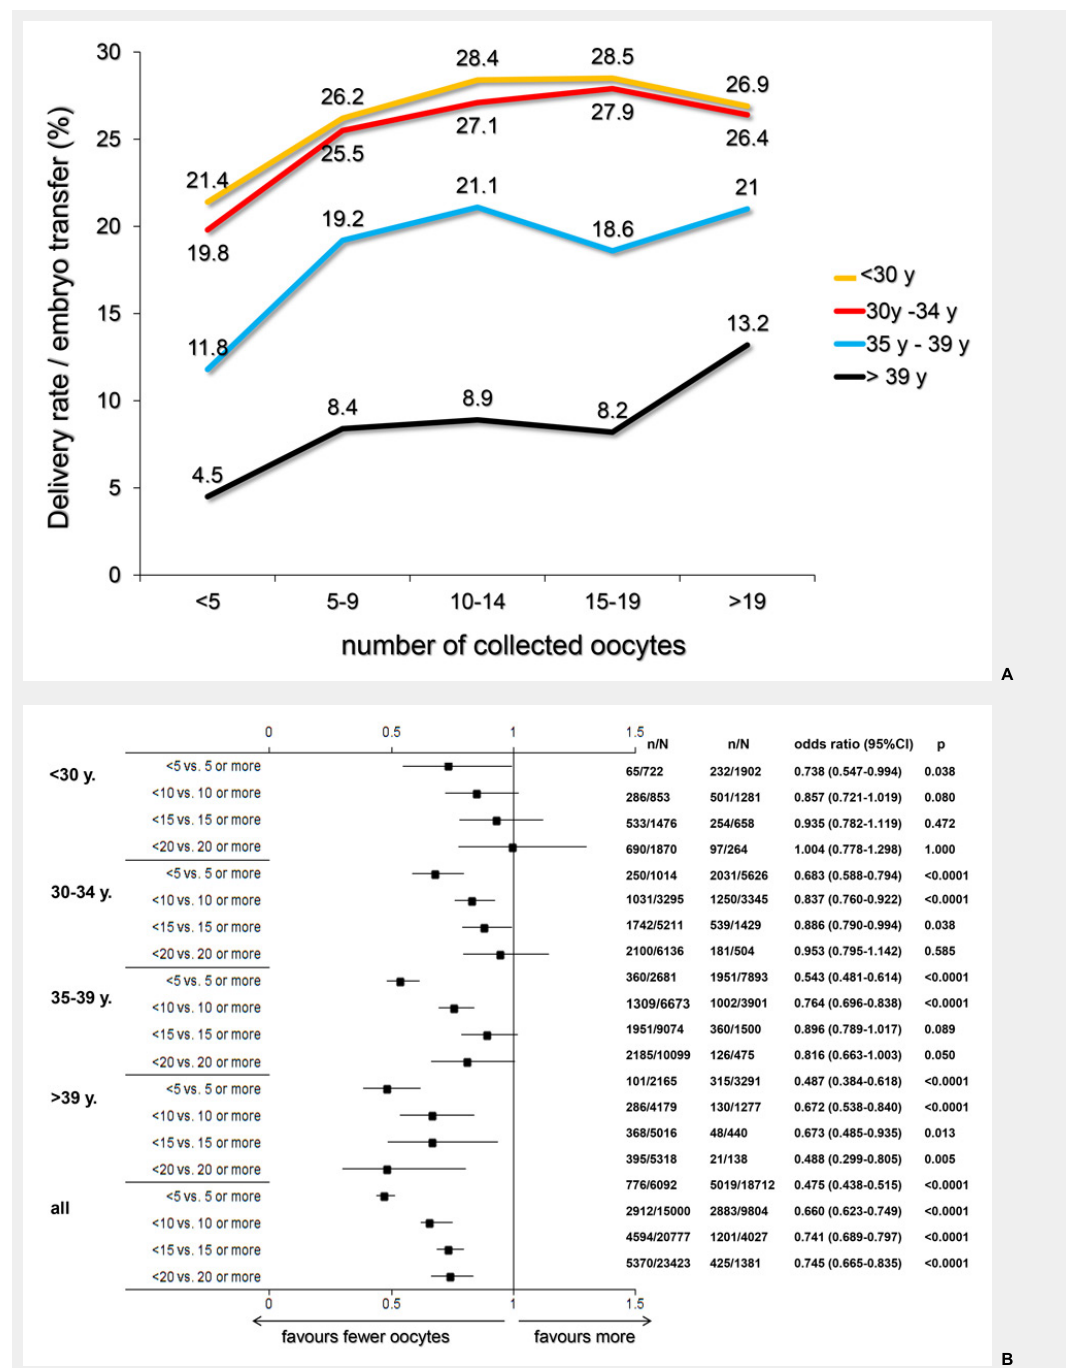
A The yearly delivery rates per embryo transfer (in %) achieved with ART from 2005 to 2012 were computed in relation to the number of collected oocytes and to the age of the infertile women during the treatment. The outcome of ART strongly depends on the age of the treated patient and to a lesser extent on the number of collected oocytes. B Delivery rates and their relationship with the number of collected oocytes and the age of the treated infertile women at oocyte collection, using the pooled FIVNAT-CH data collected between 2005 and 2012. Among all treated patients the delivery rates per embryo transfer significantly depended on the quantity of retrieved oocytes (p <0.0001), but this dependence was less pronounced among younger patients. In each age category the number of deliveries was significantly lower if fewer than five oocytes were retrieved. In all age categories (except those older than 39 years) the delivery rates were not further improved if more than 15 oocytes were